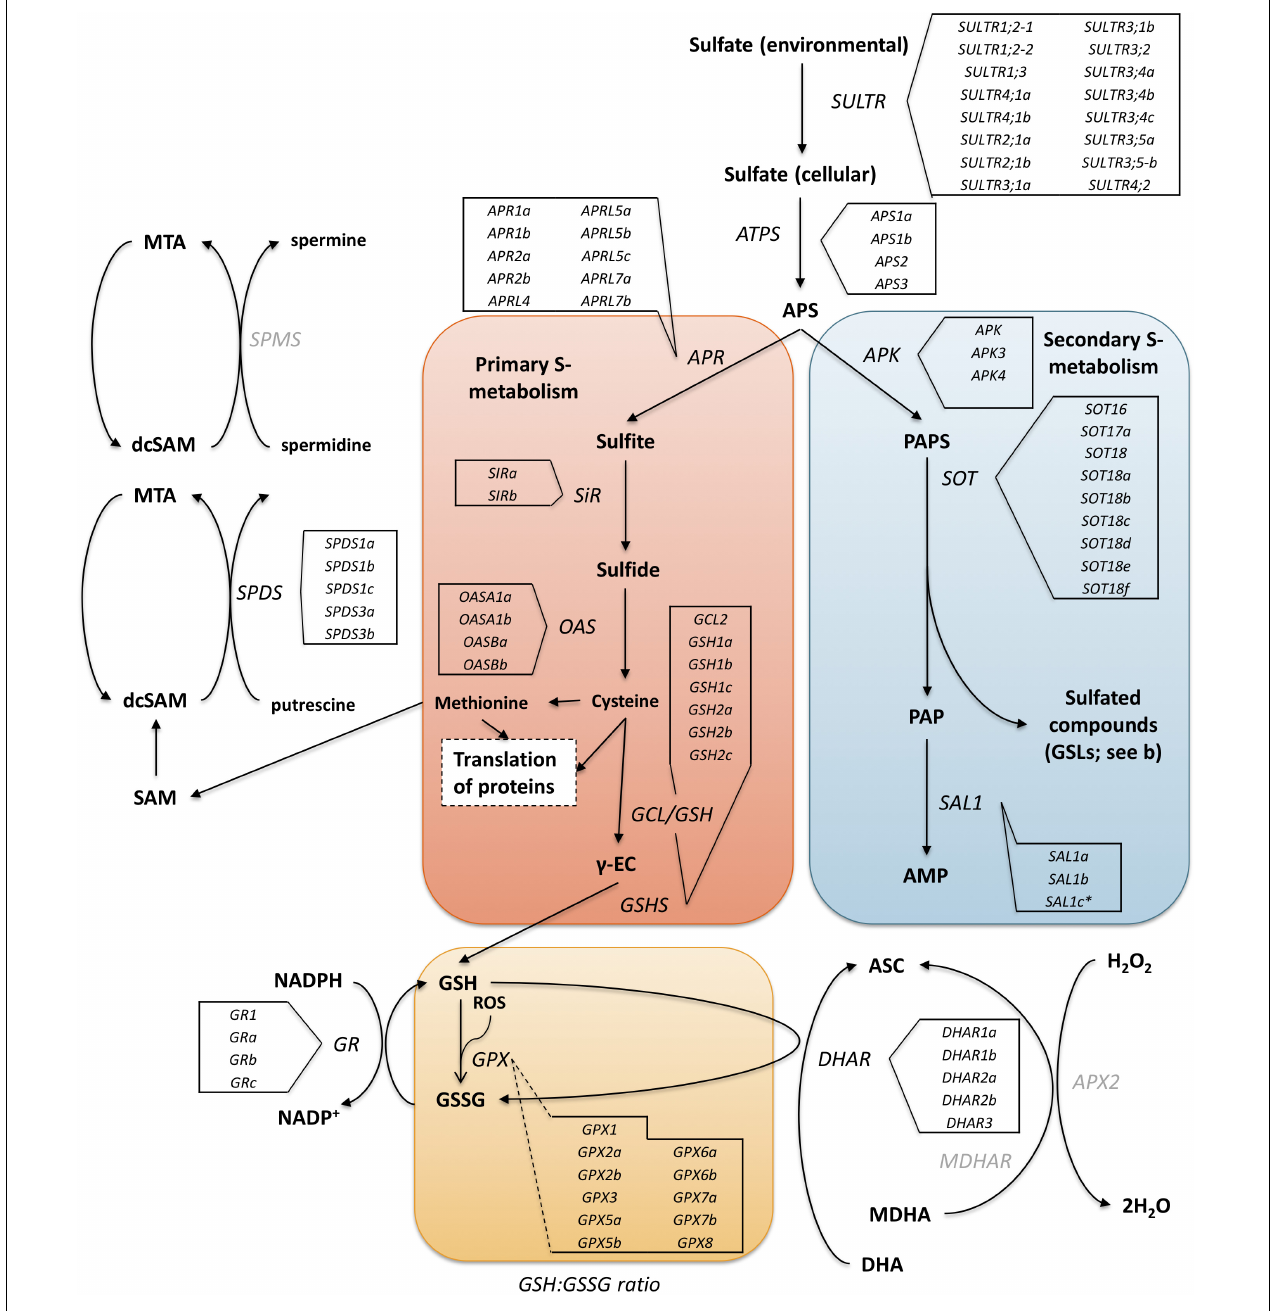
FIGURE 1 | The primary (red box) and secondary (blue box) sulfur metabolism pathways of A. thaliana with identified homologous genes within the Eruca sativa genome annotation (see boxed insets) adapted from Chan et al. (2013). Environmental sulfur is assimilated and integrated into key amino acids (cysteine and methionine) and enzymes. Sulfur metabolism is also intrinsically linked with oxidative stress via glutathione synthesis. Under stress conditions 5 (cid:48) -phosphoadenosine-3 (cid:48) -phosphate (PAP), glutathione disulfide (GSSG), and reduced glutathione (GSH) direct sulfate toward GSH production. The GSH:GSSG redox state ratio is also known to influence sulfur assimilation rates (orange box). SOT ( sulfotransferase ) genes link secondary sulfur metabolism with the final sulfation step of GSL biosynthesis, and it is thought that SAL1 plays an important role in regulating the activity of these genes through interaction with PAP. Genes with identified orthologs in the E. sativa genome annotation are written in black; those with no identified homologous sequence are written in gray. SULTR , sulfate transporter ; ATP, adenosine triphosphate; ATPS , ATP sulfurylase ; APR , APS reductase ; APK , APS kinase ; SiR , sulfite reductase ; OASTL , O-acetylserine lyase ; GCL , glutamate cysteine ligase ; γ -EC, γ -glutamyl-cysteine; GSHS , GSH synthetase ; GR , glutathione reductase ; GPX , glutathione peroxidase ; ASC, ascorbate; DHA, dehydroascorbate; DHAR , DHA reductase ; MDHA, monodehydroascorbate; MDHAR , MDHA reductase ; APX2 , ascorbate peroxidase 2 ; H 2 O 2 , hydrogen peroxide; PAPS, 5 (cid:48) -phosphoadenosine-3 (cid:48) -phosphosulfate; SAM, S-adenosyl methionine; dcSAM, decarboxylated SAM; MTA, methylthioadenosine; SPDS , spermidine synthase ; SPMS , spermine synthase . *Indicates a novel gene identification within the genome annotation.